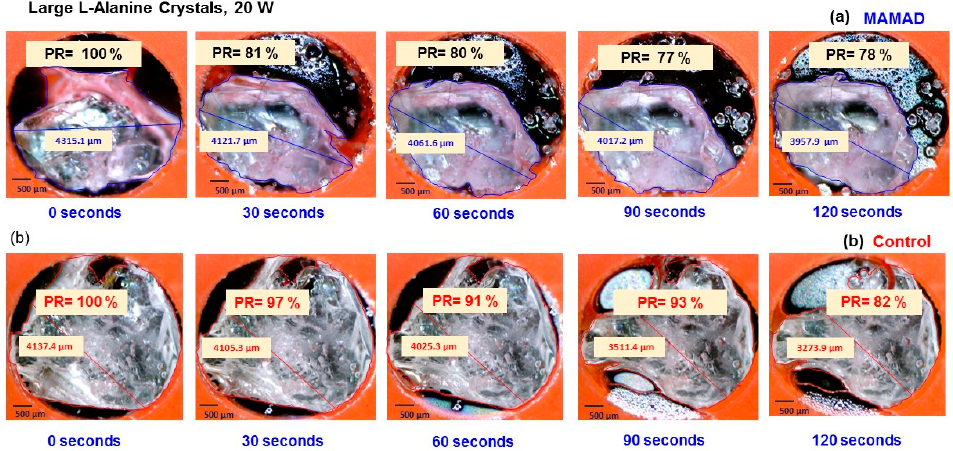
Figure 7. Optical images of Large L -alanine crystals on 2D poly(methyl)methacrylate PMMA platforms ( a ) with gold nanoparticles ( b ) and without gold nanoparticles at 20 W. PR = Percentage Retention.